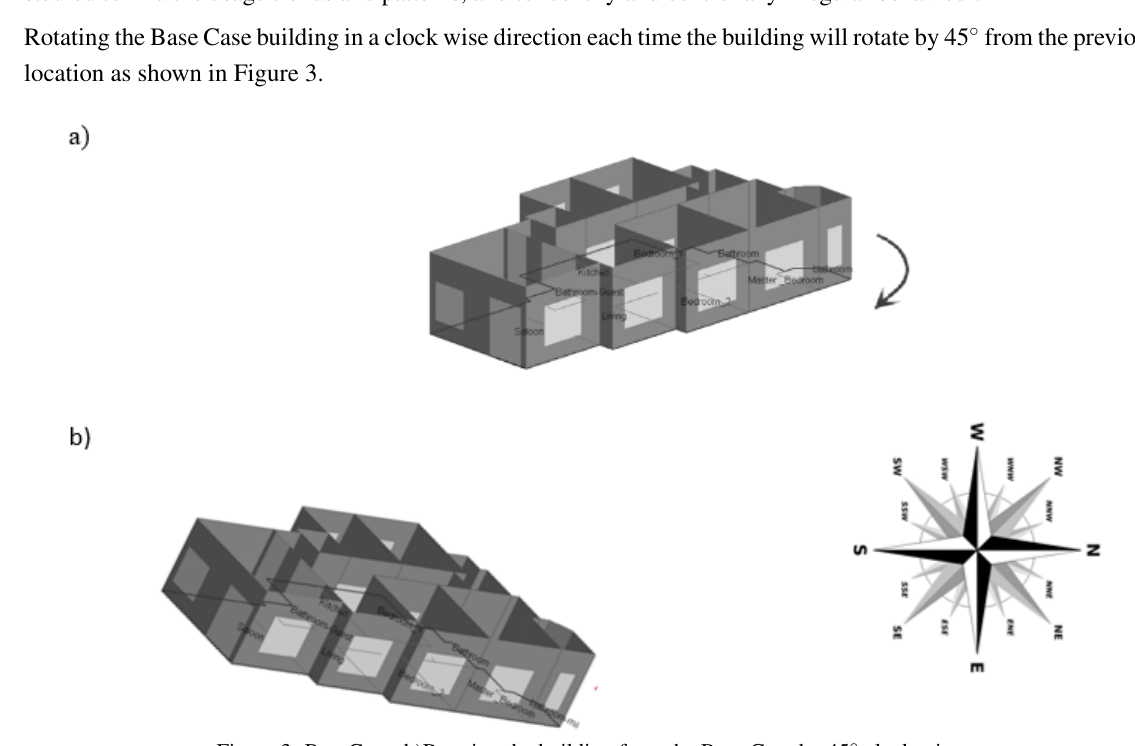
Figure 3. BaseCase. b)Rotating the building from the Base Case by 45 ◦ clock